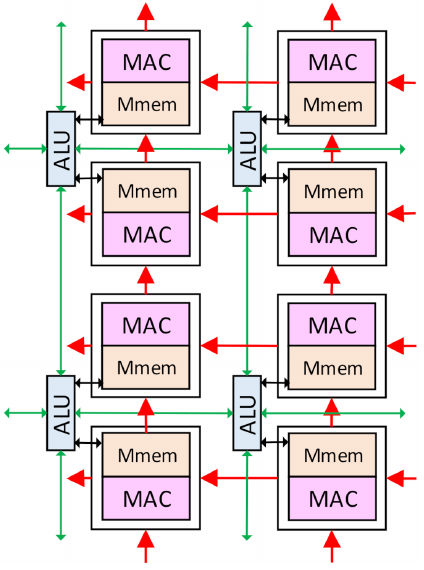
Figure 4. The connection of the ALUs and the